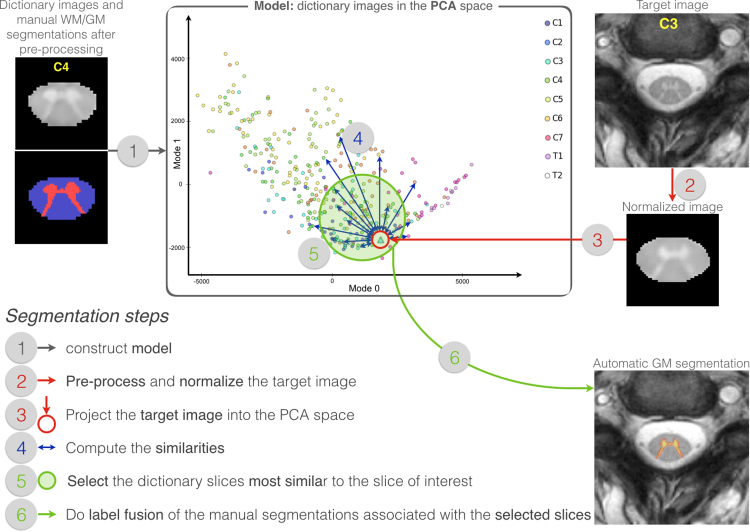
Multi-atlas based segmentation method.